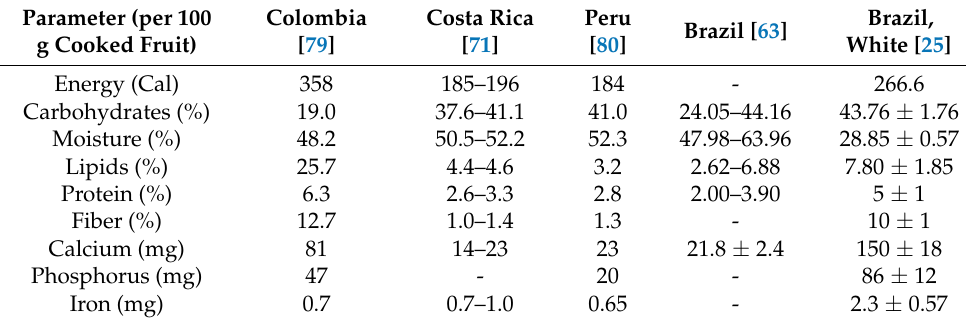
Table 4. Nutritional composition of B. gasipaes fruit from different origins.